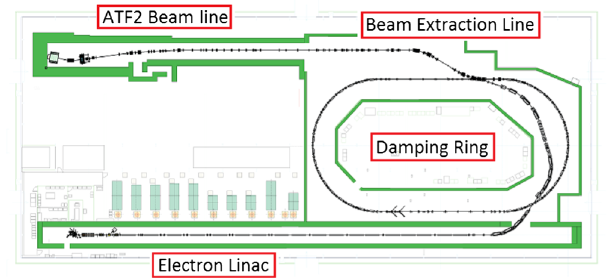
FIG. 1. Accelerator complex of KEK-ATF, consisting of an electron linac, a damping ring, a beam extraction line, and the ATF2 beam